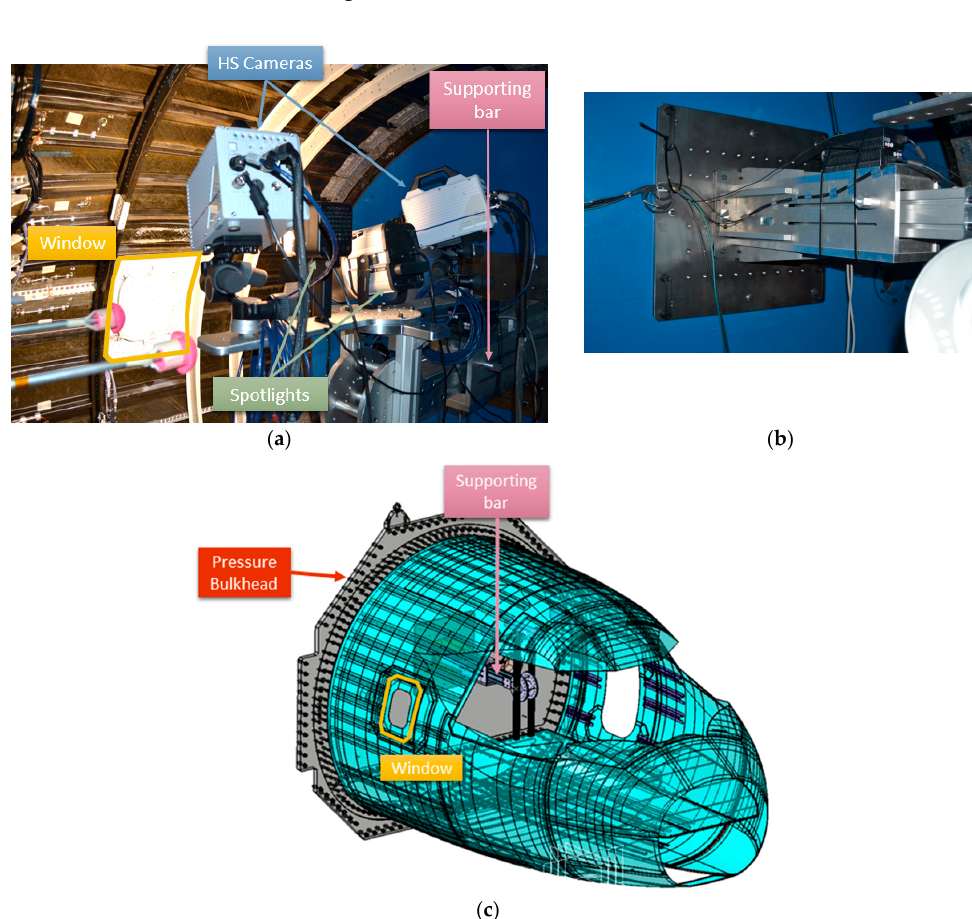
Figure 9. ( a ) Optical system on the supporting bar; ( b ) supporting bar attachment to the bulkhead; and ( c ) model of the global cockpit demonstrator